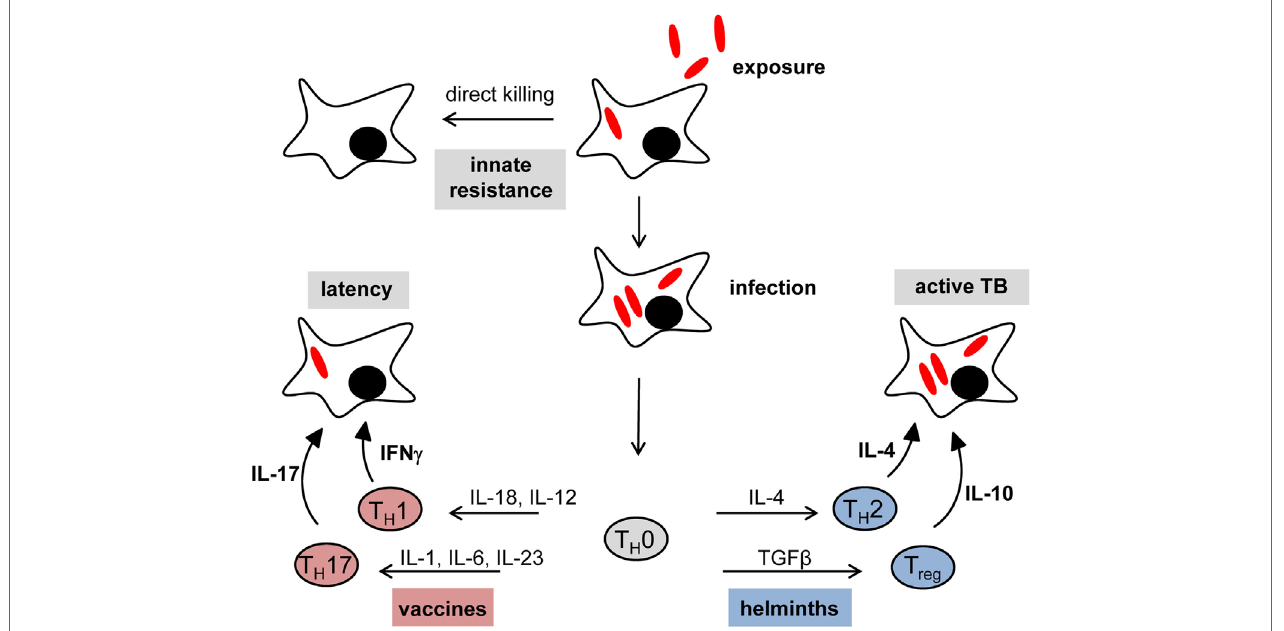
FiGURe 1 | Immune checkpoints in tuberculosis: impact of vaccination and helminth infection. In many cases, the initial exposure to mycobacteria results in direct killing by alveolar macrophages without the need for an adaptive immune response (innate resistance). Failure of initial innate control mechanisms leads to primary infection. The set of chemokines and cytokines produced by innate immune cells are crucial for the shaping of an effective adaptive immune response. The Th1 key cytokine IFN γ is necessary to establish and maintain latent infection. Moreover, IL-17 was found to be important for vaccination-induced protection against tuberculosis. However, concomitant helminth infection shifts the immune system toward a T helper type 2 (Th2)/regulatory T cells (Treg) response rather than a protective Th1/Th17 immune status, which leads to a higher risk to develop active disease and interferes with successful vaccination